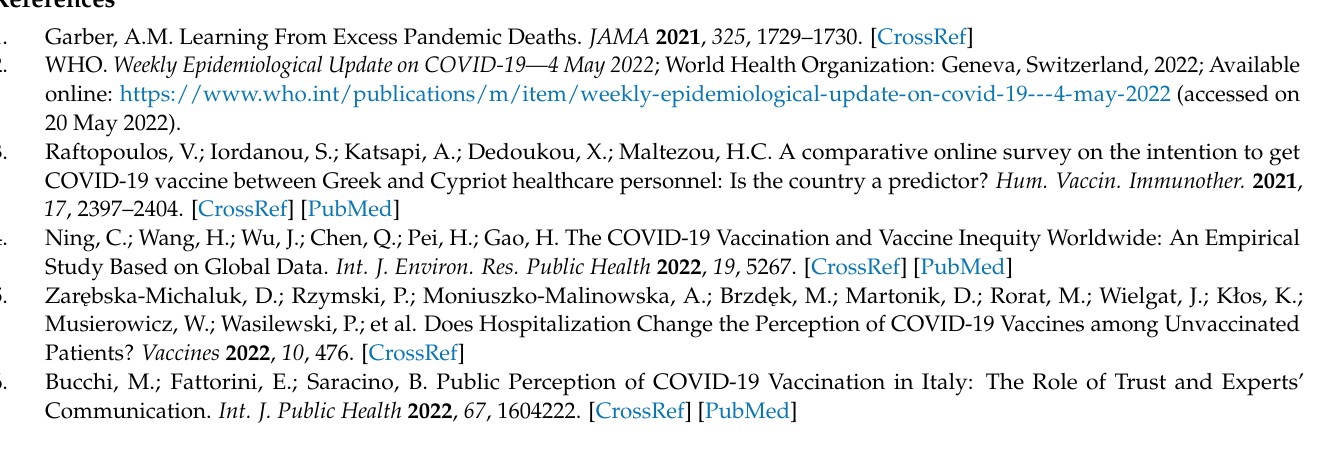
Table S3. Correlation of other sources of information about COVID-19 vaccination with COVID-19 vaccination